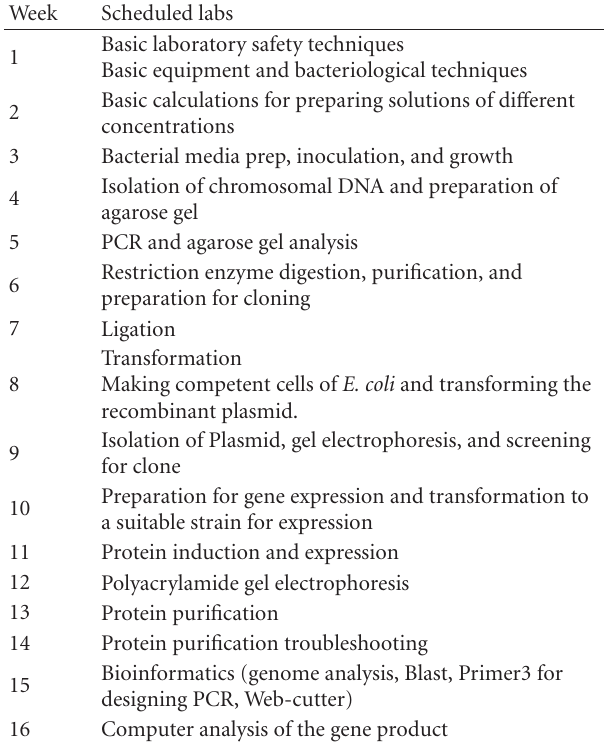
Table 1: Scheduled labs in